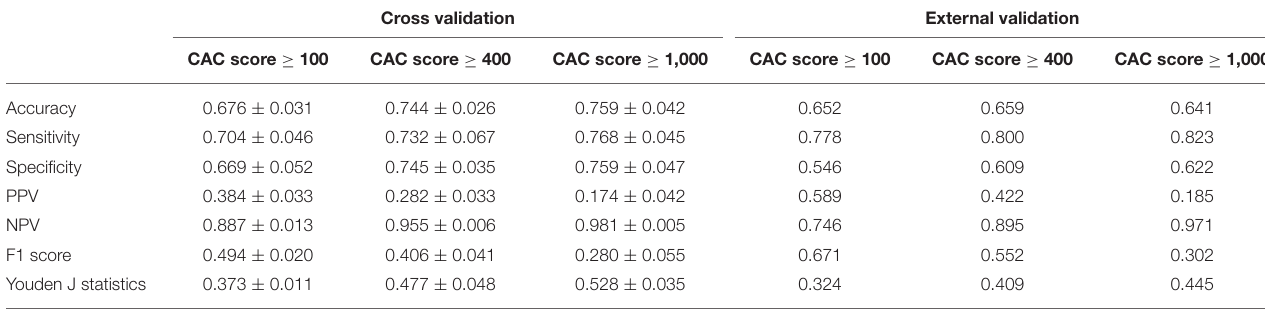
TABLE 2 | Performance of the models when the Youden J statistics was at the